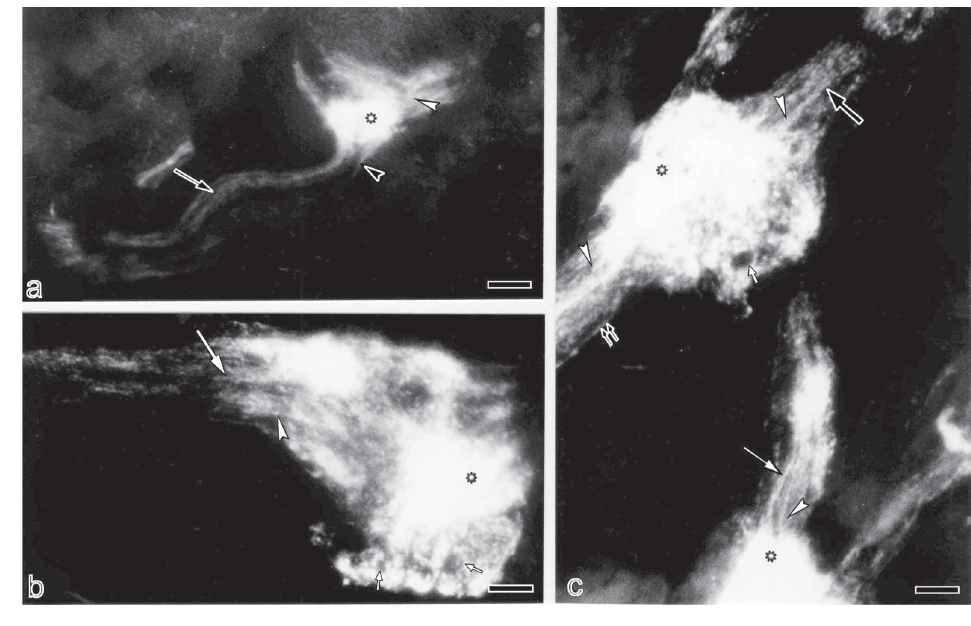
Figure 3. Photomicrographs of transverse sections of the ven- tral region of the pedal muscle of Megalobulimus oblongus showing 5-hydroxytryptamine (5-HT) immunoreactivity. a , Positive immunoreactivity in nerve fibers (arrows) and in some ganglia (arrowheads) of the pedal plexus. b , Detail from the pedal muscle. Note 5-HT immunoreactive nerves (arrow- heads) and single varicose axons (arrows) over the muscle cells. c , Detail from the ventral aspect of the foot, showing 5- HT immunoreactive varicose axons (arrowheads) of the sub- epithelial plexus and in other larger fibers (arrow). E = ventral epithelium. Bars: a = 100 µm, b = 50 µm, c = 20